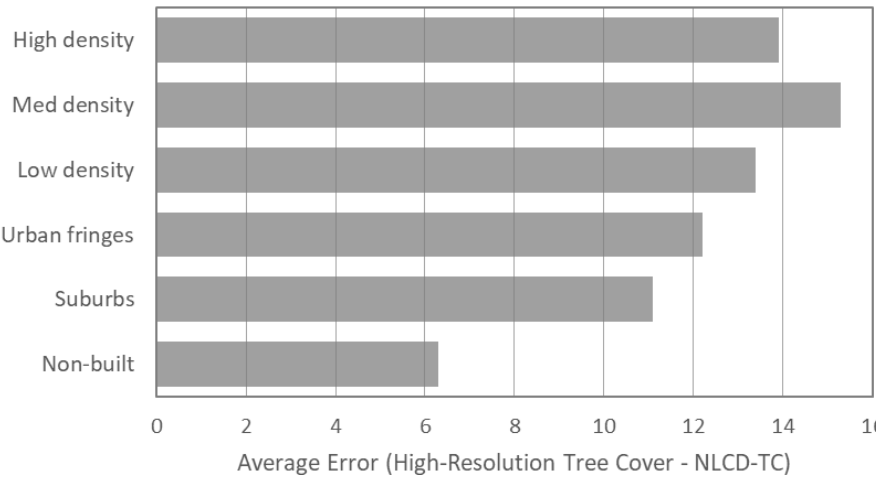
Figure 5. Average National Land Cover Database-Tree Canopy error (deviation by % when compared to high-resolution derived data) by urban density.